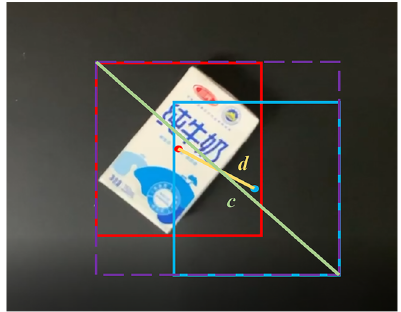
Figure 9. The schematic diagram of DIoU .